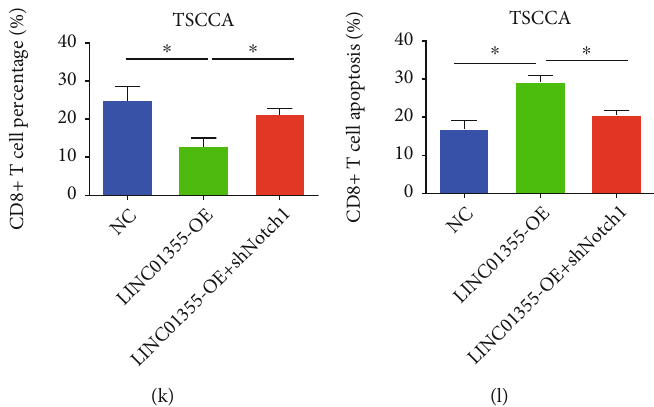
Figure 6: Knockdown of Notch1 inhibited the e ff ect of LINC01355 on OSCC cells. (a) The Notch1 mRNA expression was assessed in CAL27 cells transfected with Notch1 shRNA or LINC01355 overexpression plasmid. (b) CAL27 cell viability was assessed by CCK-8 assay. (c) The Notch1 mRNA expression level was detected in TSCCA cells transfected with Notch1 shRNA or LINC01355 overexpression plasmid. (d) TSCCA cell viability was assessed using CCK-8 assay. (e, f) OSCC cell invasion. (g) The cytotoxicity of CD8+ T cells cocultured with CAL27 cells. (h) The proliferation of CD8+ T cells cocultured with CAL27 cells. (i) The apoptosis of CD8+ T cells cocultured with CAL27 cells. (j) The cytotoxicity of CD8+ T cells cocultured with TSCCA cells. (k) The proliferation of CD8+ T cells cocultured with TSCCA cells. (l) The apoptosis of CD8+ T cells cocultured with TSCCA cells. ∗ p < 0 : 05